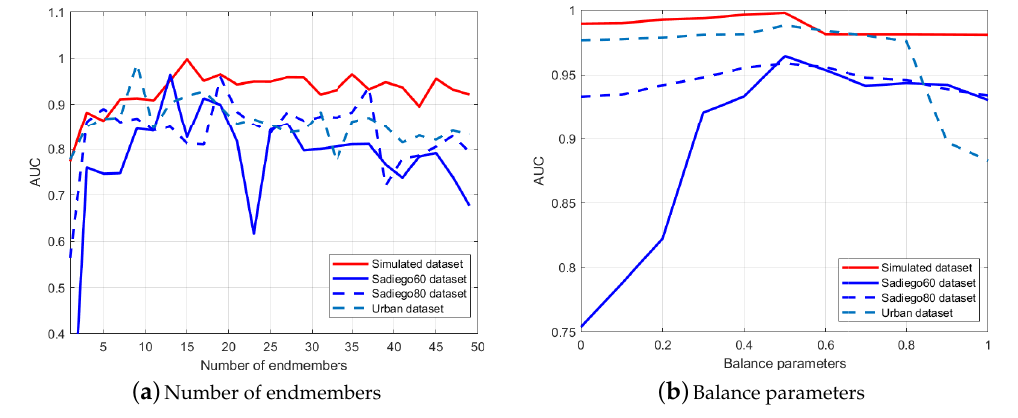
Figure 19. Analysis of main parameters.